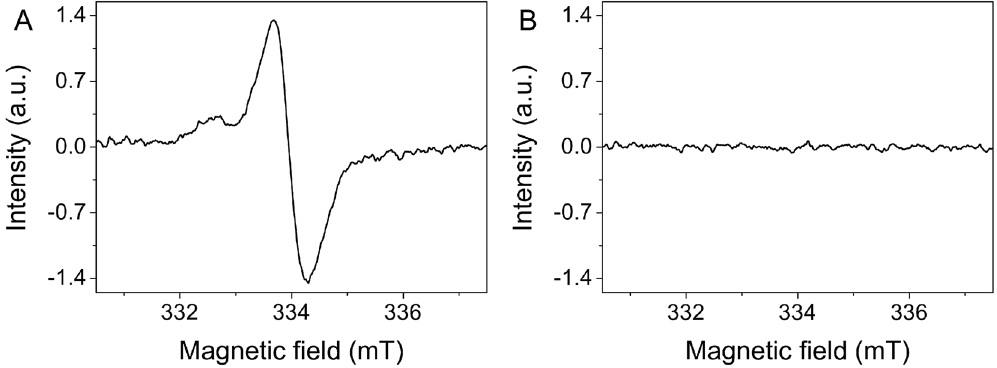
Figure 5. Loss of melanin in dividing melanoma cells. EPR spectra of 10 6 heavily-pigmented SKMEL-188 cells immediately after melanin synthesis ( A ), and after 14 days of culture ( B ) under such conditions the cells did not synthesize melanin. As evident, no detectable melanin signal was observed in the cells after two weeks of culture indicating the loss of pigment by the cells due to consecutive cell division.